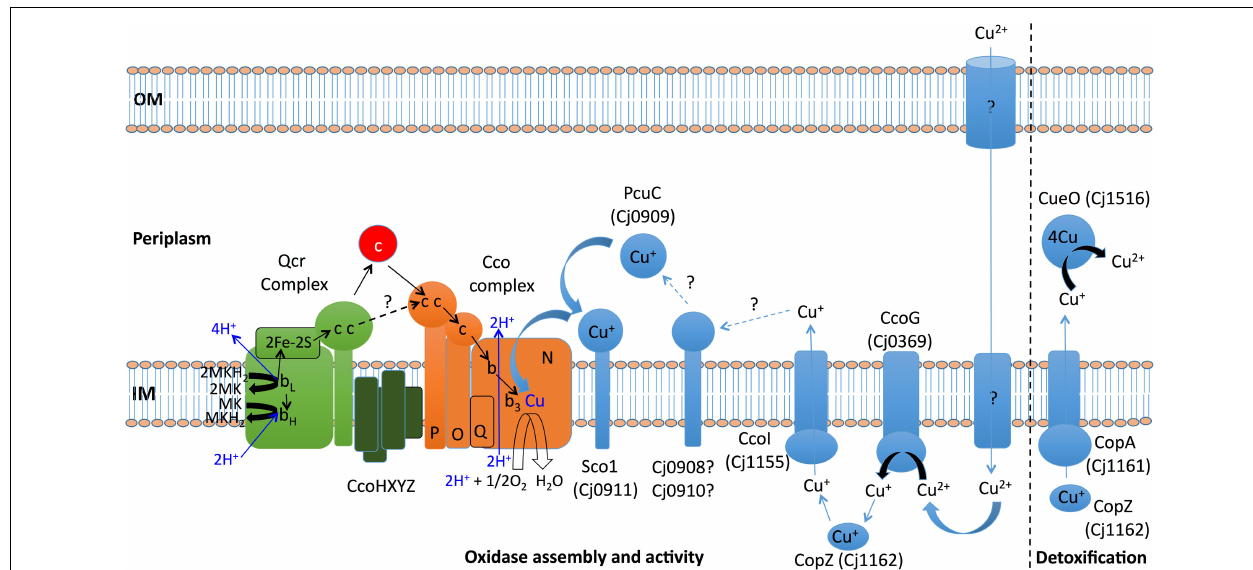
FIGURE 8 | Model for copper handling and homeostasis in C. jejuni NCTC 11168. Copper must be transported from the environment into the cell, but the mechanism is currently unknown as there is no CcoA importer in C. jejuni . Copper homeostasis/detoxification is achieved by the combined action of the CopA ATP-driven efflux pump, receiving copper from the cytoplasmic chaperone CopZ and the periplasmic multi-copper oxidase CueO (Cj1516) which oxidises toxic cupric ions to less toxic cupric ions. CcoG (Cj0369) acts as a reductase that probably passes cuprous ions to CopZ. CpoZ is also thought to interact with CcoI, a specific efflux pump that is essential for copper delivery to the periplasm for transfer to the Cco enzyme complex, possibly via potential reductases Cj0908 and Cj0910 and copper chaperones PcuC (Cj0909) and Sco1 (Cj0911). Sco1 delivers cuprous copper to the CcoN subunit of the oxidase complex to form the bi-nuclear catalytic centre of the enzyme. Newly identified genes in this study encode three proteins (CcoXYZ) that might interact with both the Qcr and oxidase, perhaps forming a supercomplex. Direct copper handling proteins are shown in light blue, with light blue arrows depicting the transfer of copper ions. Electron transfers are shown as black arrows. Dark blue arrows show proton binding and release or direct proton translocation associated with electron transfer from Qcr to the oxidase complex. Soluble cytochromes c in the periplasm are shown as a red circle. The possibility of direct electron transfer between Qcr and oxidase is indicated by a dashed black line. OM, outer membrane; IM, inner (cytoplasmic) membrane.